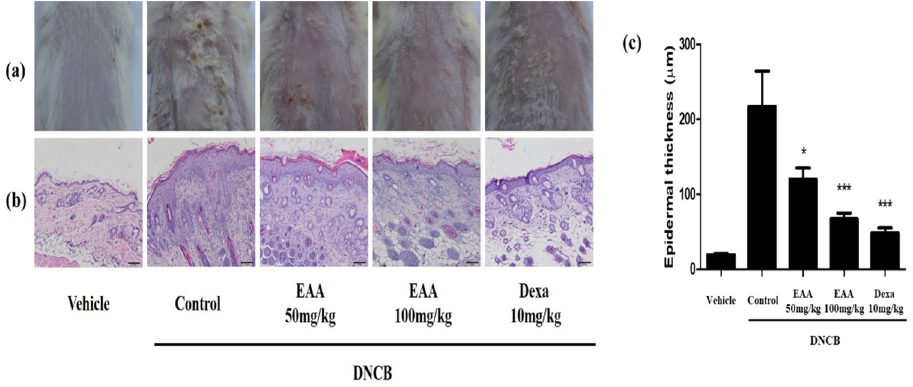
Figure 4. Inhibitory effects of EAA on DNCB-induced AD in the in vivo model. Representative pho- tographs of dorsal skin lesions and histopathological observations in DNCN-induced AD mice with the vehicle (solvent), control (DNCB-induced AD), EAA (50 and 100 mg/kg), and dexamethasone (10 mg/kg) via oral administration. ( a ) Dorsal skin photographs taken at the end of the experiment showing AD-like skin lesions. ( b ) The AD dorsal skin lesions were sectioned and stained with H&E (magnification ×40, scale bar: 100 µm). ( c ) Measurement of the epidermal thickness. Bars with different letters indicate statistically significant differences at * p < 0.05 and *** p < 0.001 compared with the control group (solvent).